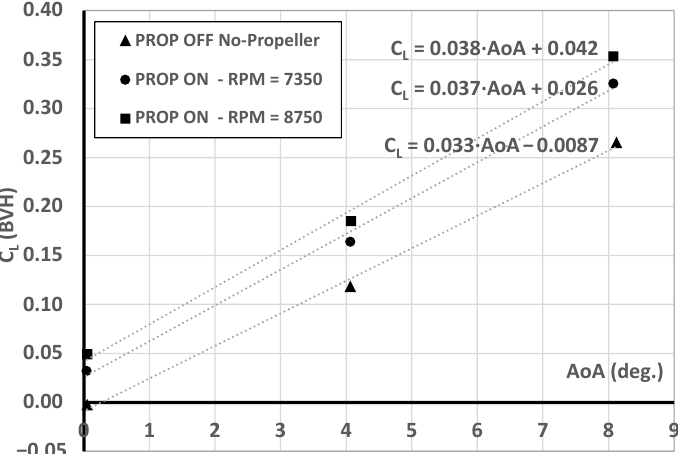
Figure 13. Global propulsive effects (direct and indirect) on the lift coefficient curves for two engine design points and power-off conditions, Re = 315,000, IU rotation at two RPM settings.